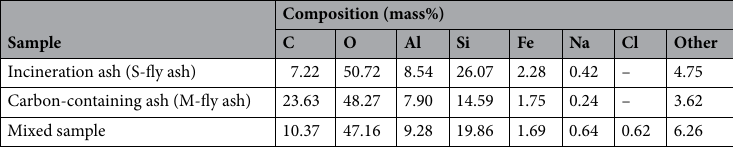
Table 1. Chemical composition of fly ash and garnet samples determined by XRF.